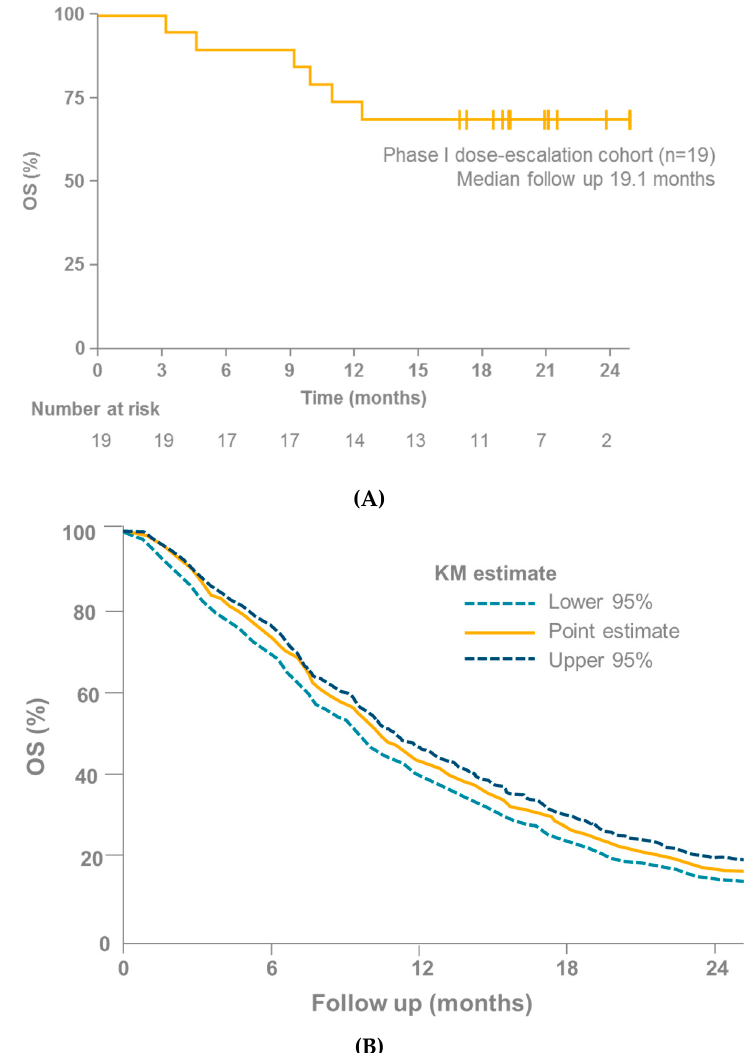
Figure 5. ( A ) OS in 19 patients with mUM receiving tebentafusp as part of the IMCgp100-102 trial [4]. ( B ) OS in 915 patients with mUM receiving immunotherapy, kinase inhibitors, anti-angiogenic therapy, chemotherapy or liver-directed therapy from 29 different trials [42]; KM, Kaplan–Meier; mUM, Metastatic uveal melanoma; OS, Overall survival.